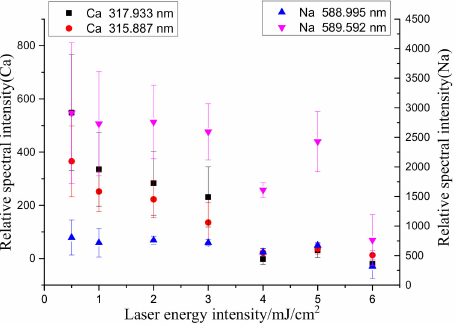
Figure 8. E ff ects of delay time on the relative spectral intensity of each element.